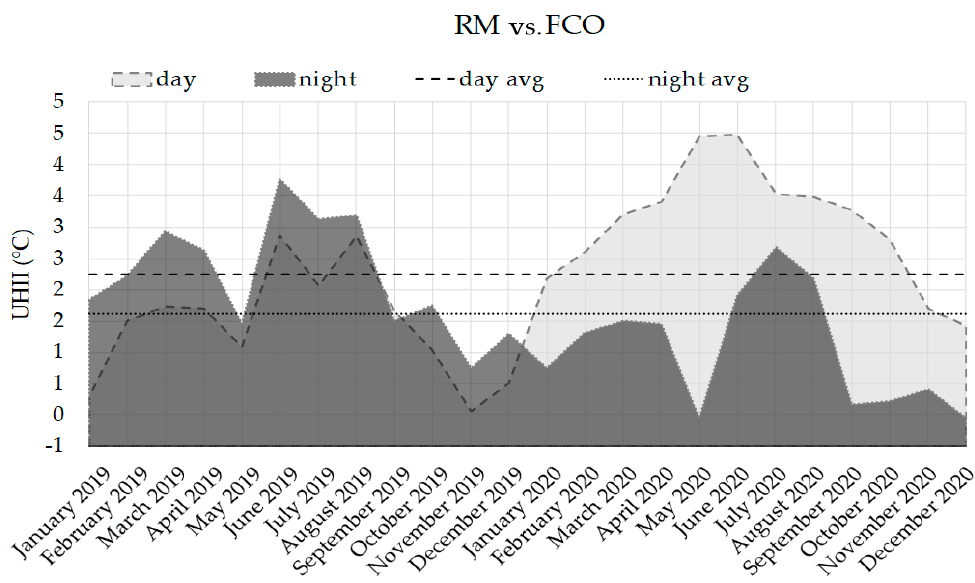
Figure 6. UHII comparison of Rome and Fiumicino during the day and night. Furthermore, the percentage differences between the average values of UHII calcu- lated in the two-year registration period are equal to 110%, referring to the day, and − 52.8%, referring to the night.